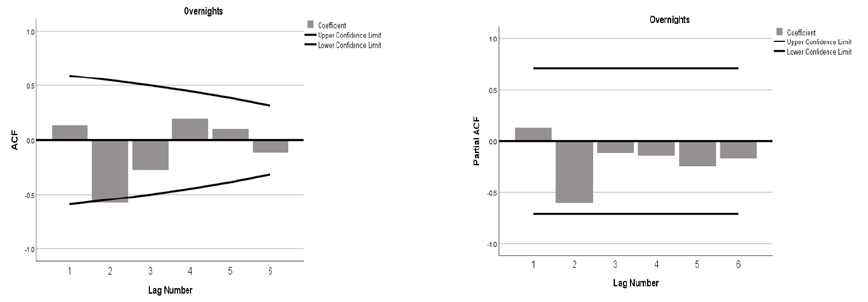
Figure 10. Correlogram of international overnights (first differences) ACF I PACF.